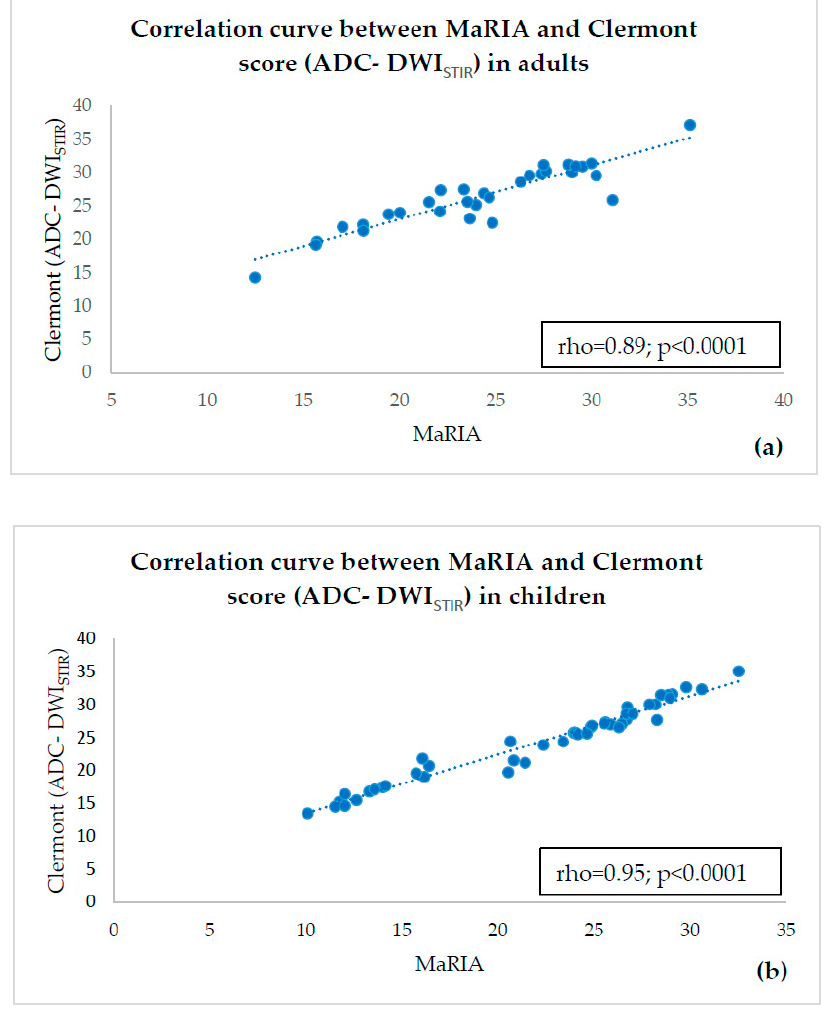
Figure 5. Correlation curve between MaRIA and ADC-DWI STIR —based Clermont score in adults ( a ) and children ( b ) showing high correlation.